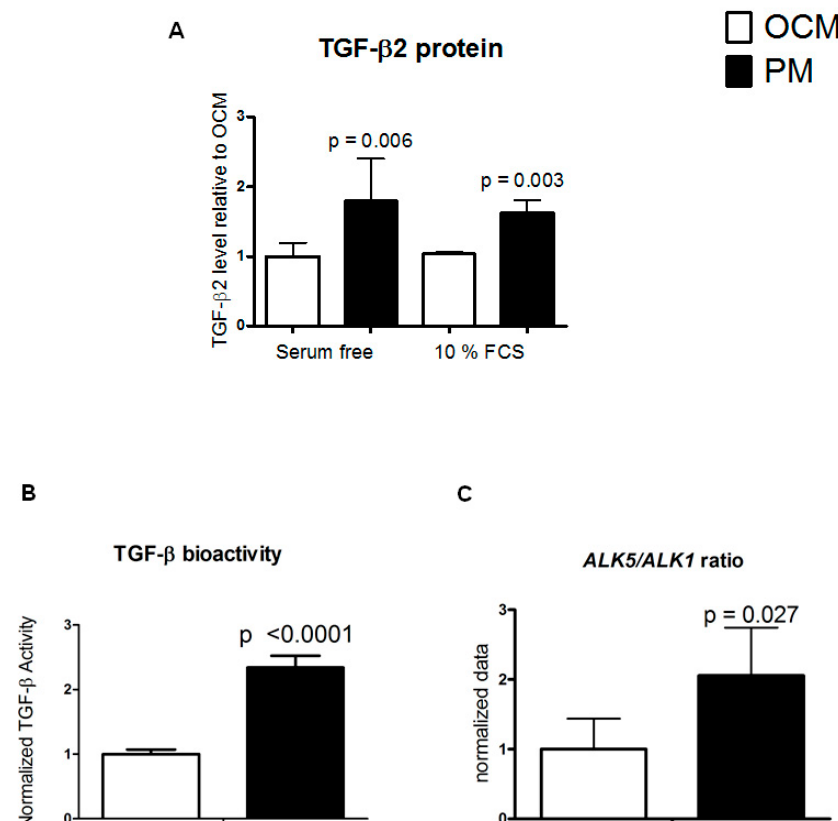
Figure 2. Physosmotic culture medium (PM) increases TGF- β 2 secretion and TGF- β bioactivity in HACs. In HACs cultured for seven days (serum-free cultures on the left and 10% FCS cultures on the right) TGF- β 2 protein levels were determined by specific TGF- β 2 ELISA in PM (black bars) or OCM (white bars) ( A ). TGF- β bioactivity was determined by TGF- β bioassay in 72 h serum starved conditioned medium from PM and OCM HAC cultures ( B ). Corresponding ALK5/ALK1 gene expression ratio was determined in samples from Figure 1 ( C ). Data are from 3 donors measured in duplicate and are presented as mean ± standard deviation relative to control OCM conditions.